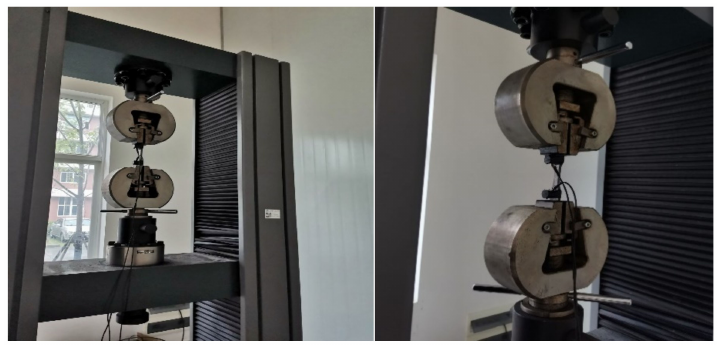
Figure 2. Tensile testing